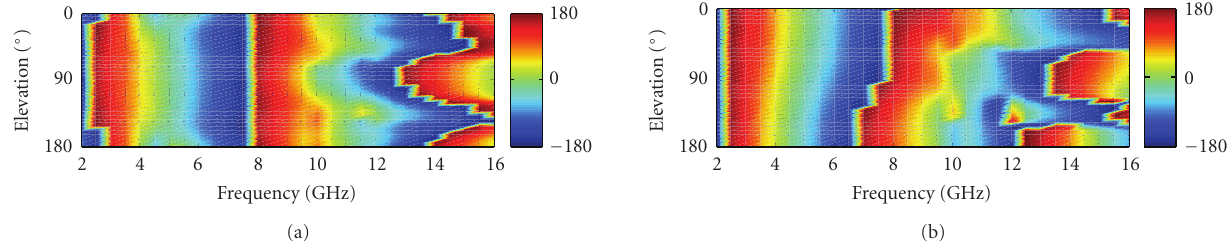
Figure 8: Azimuth-averaged SC argument of ENSTA bicone antenna ( d = 50mm): (a) exact computation and (b) computation by means of scattered